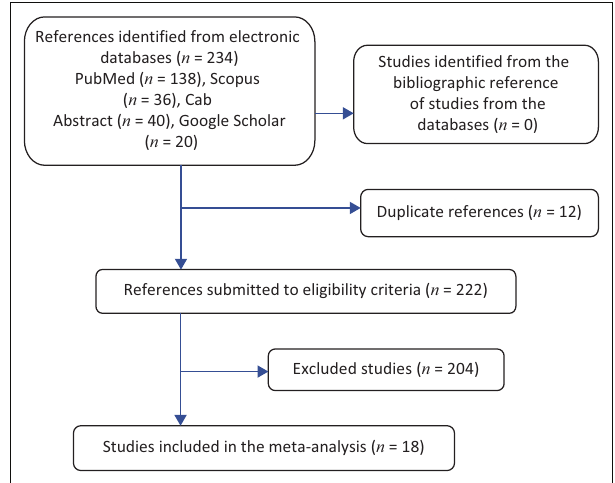
FIGURE 1: Workflow for selection of studies from various